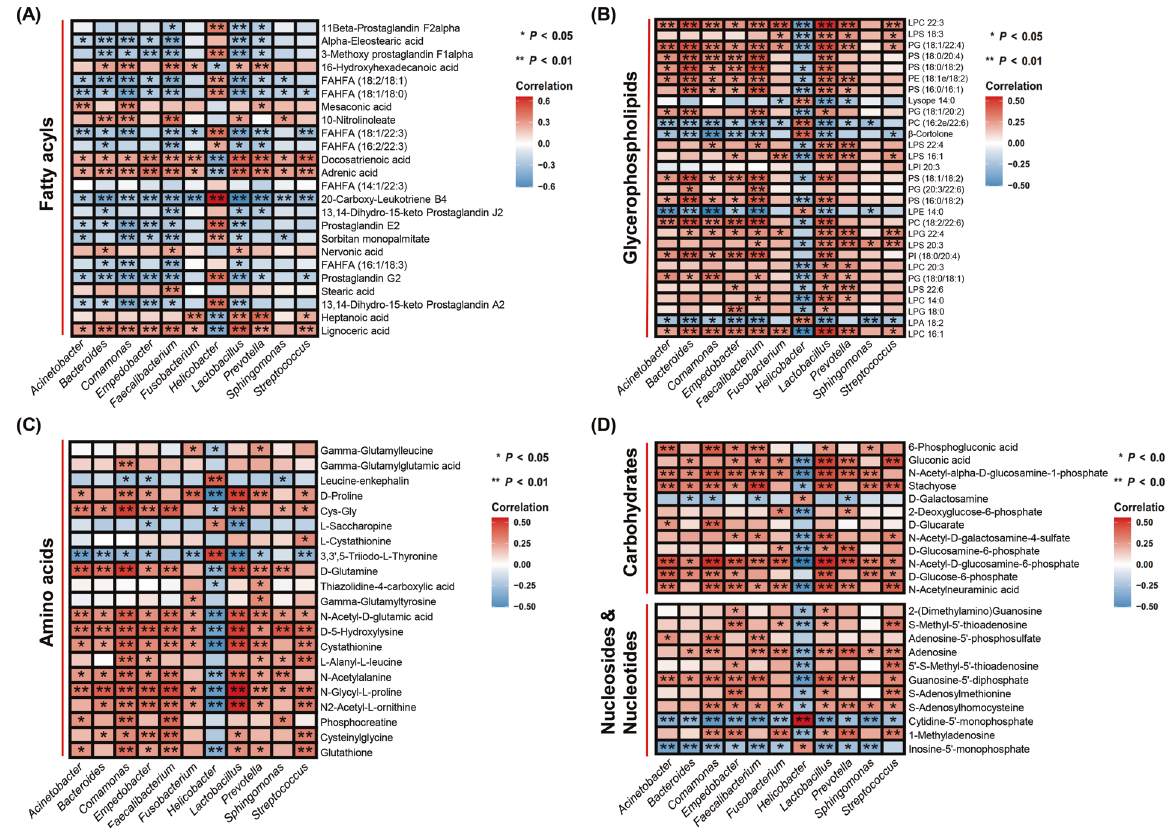
Fig. 7 The analysis of correlation between differential genera and metabolites in different classes. A – D The analysis of correlation between 11 differential genera and discriminative metabolites in the classes of fatty acyls ( n = 24) ( A ), differential glycerophospholipids ( n = 29) ( B ), amino acids ( n = 21) ( C ), carbohydrates ( n = 12), nucleosides ( n = 7), and nucleotides ( n = 4) ( D ). Red, positive correlations; blue, negative correlations. * P value < 0.05; ** P value <